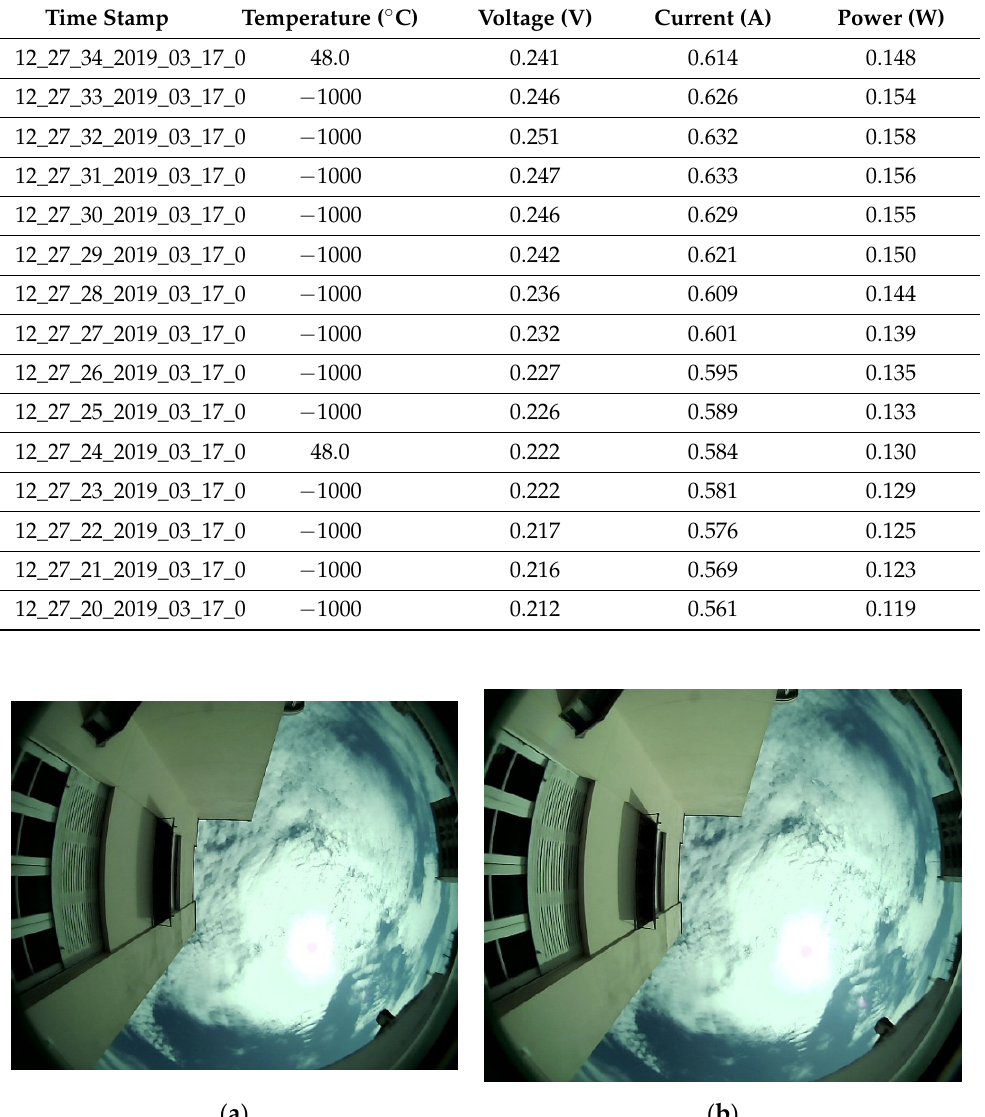
Table 3. Example of numeric data pertaining to one event structure.